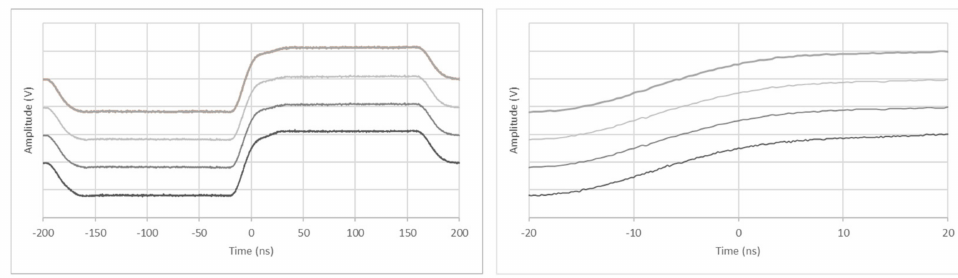
Figure 11. Phase equality of a zero-delay signal on all four synchronized